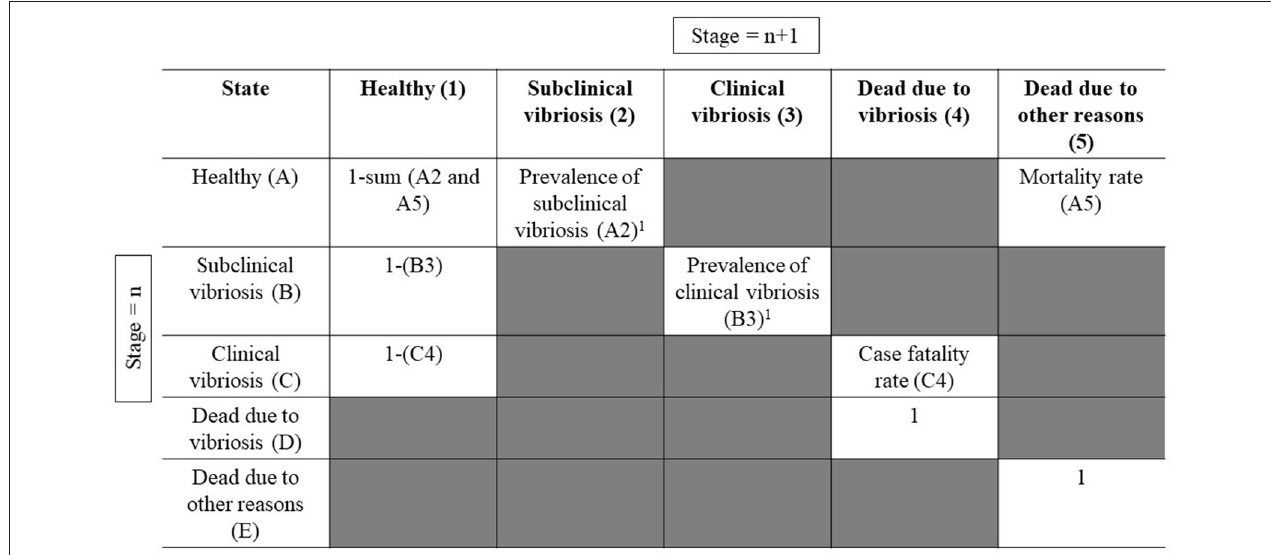
FIGURE 2 | This transition matrix was adapted from a previous study (6). The state of fish at stage ( n + 1) is dependent on its state at the previous stage ( n ). From the figure above, we can see that at stage n , a fish in a healthy state (cell A) can be subclinically infected with vibriosis (cell 2) at stage ( n + 1), determined by the prevalence of subclinical vibriosis (A2). Within the following 2 weeks of subclinical infection with vibriosis (cell B), we assume that there will be a response from the fish’s immune system, such that it will either become healthy (cell 1) or clinically infected with vibriosis (cell 3), determined by the prevalence of clinical vibriosis (B3). Within 2 weeks after acquiring a clinical infection with vibriosis (cell C), a fish can either become healthy (cell 1) or die (cell 4), which is determined by the case fatality rate (C4). If the state of the fish implies that it was dead in the previous stage ( n ), it will remain the same in the following stages (D4 and D5). 1 Indicates differences in the rate of infection, depending on the month of grow-out (